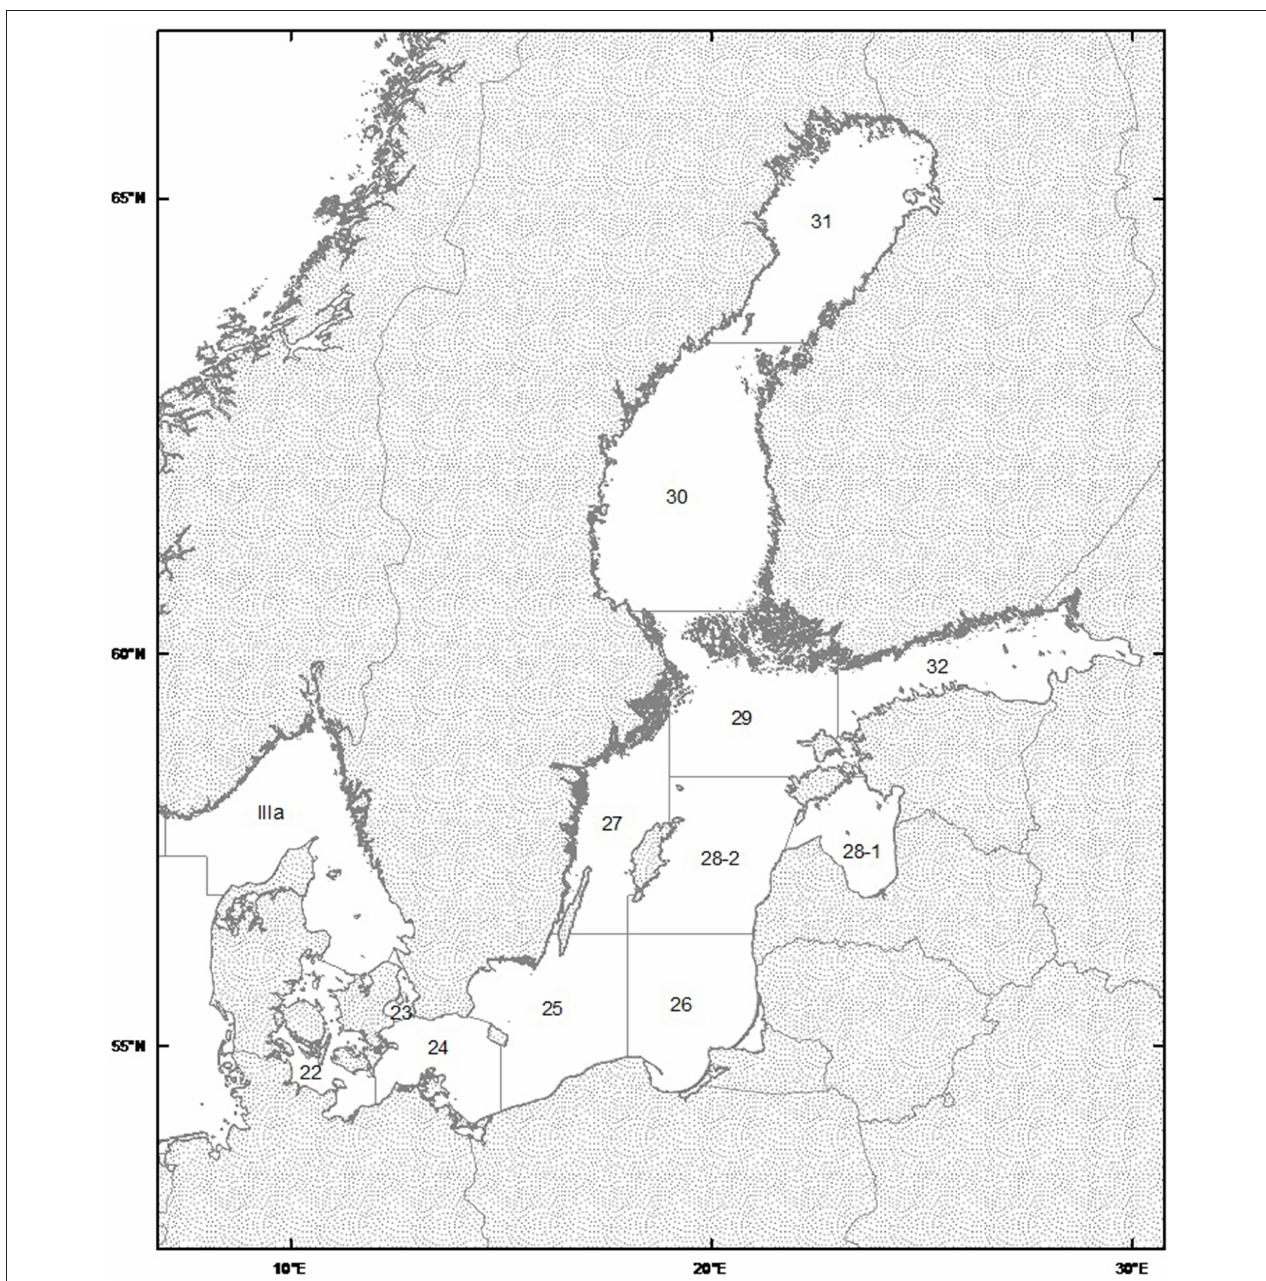
FIGURE 1 | Map of ICES Statistical area for the Baltic Sea (http://ices.dk/marine-data/maps/Pages/default.aspx). Courtesy of International Council of the Exploration of the